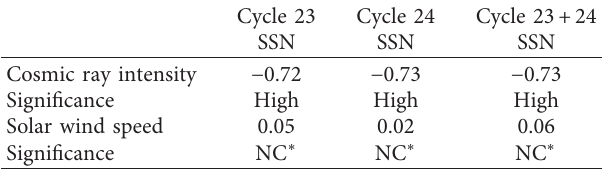
Table 1: The correlation coefficients between the time series of sunspot numbers with cosmic ray intensity and solar wind speed. Cycle 23 Cycle 24 Cosmic ray